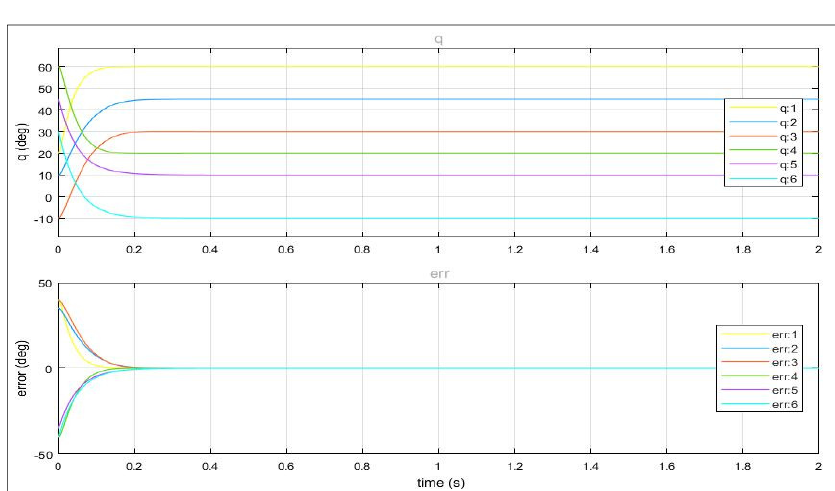
Fig. 10. Joints Torques of Step Input.